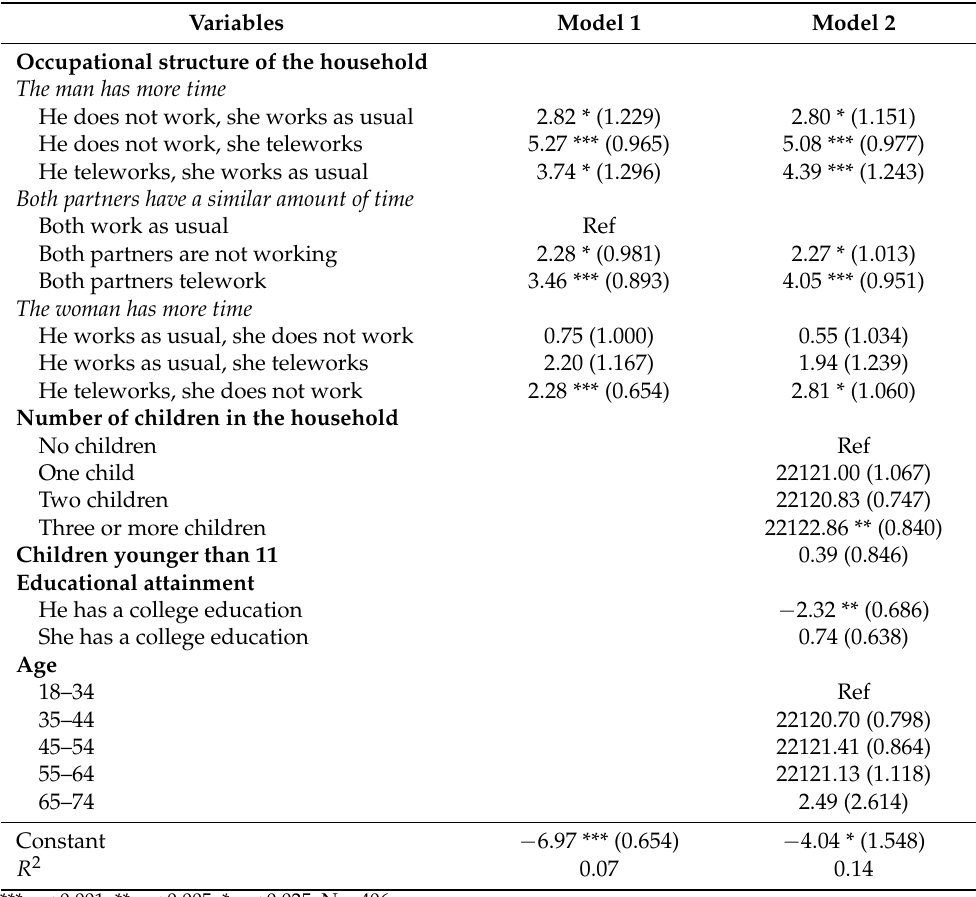
Table 2. Results from OLS regression on the division of domestic